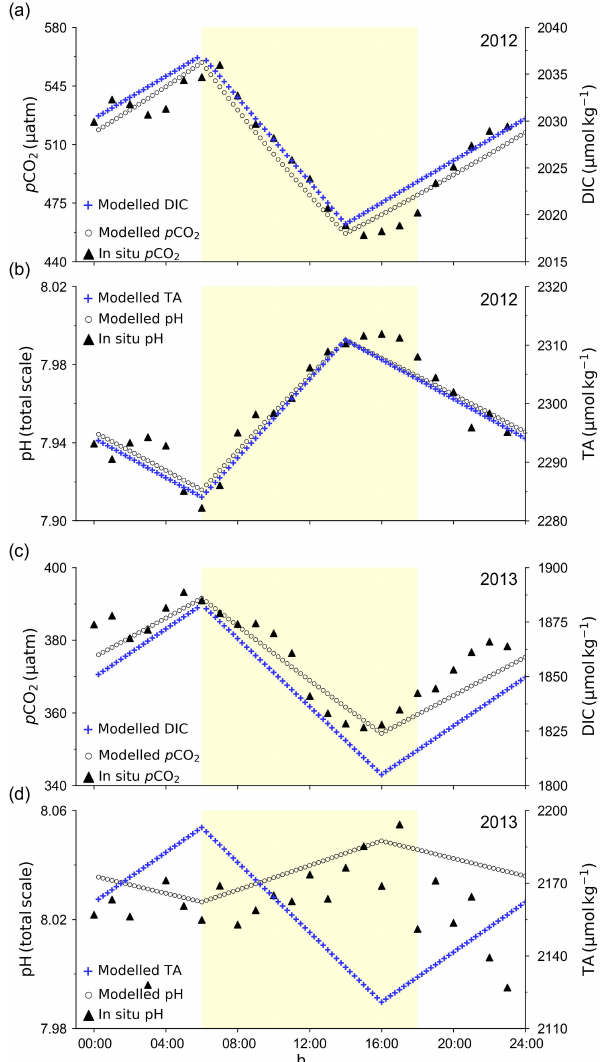
Figure 5. Expected diel behavior of the carbonate system in 2012 (a, b) and 2013 (c, d) , based on measured parameters. Mod- eled parameters are shown as blue crosses and empty circles; the reference parameter used to adjust the model is shown in black tri- angles. Shaded area represents daylight hours.